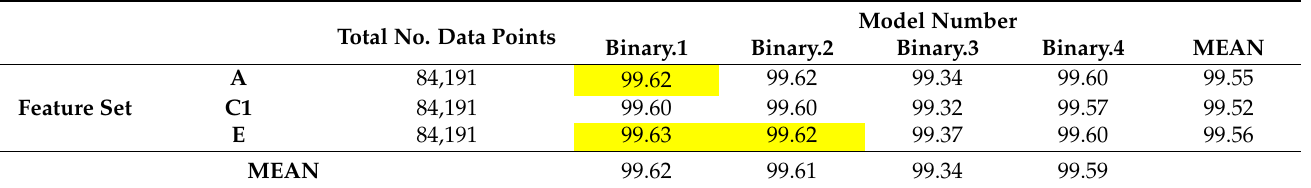
Table 6. A summary of Feature Sets A, E and H pair with each model for the binary classification problem, tested using 10-fold cross-validation. The mean percentage accuracy values for each feature set and model number are also shown. The results highlighted in yellow show the top 3 performing models in terms of mean percentage accuracy.